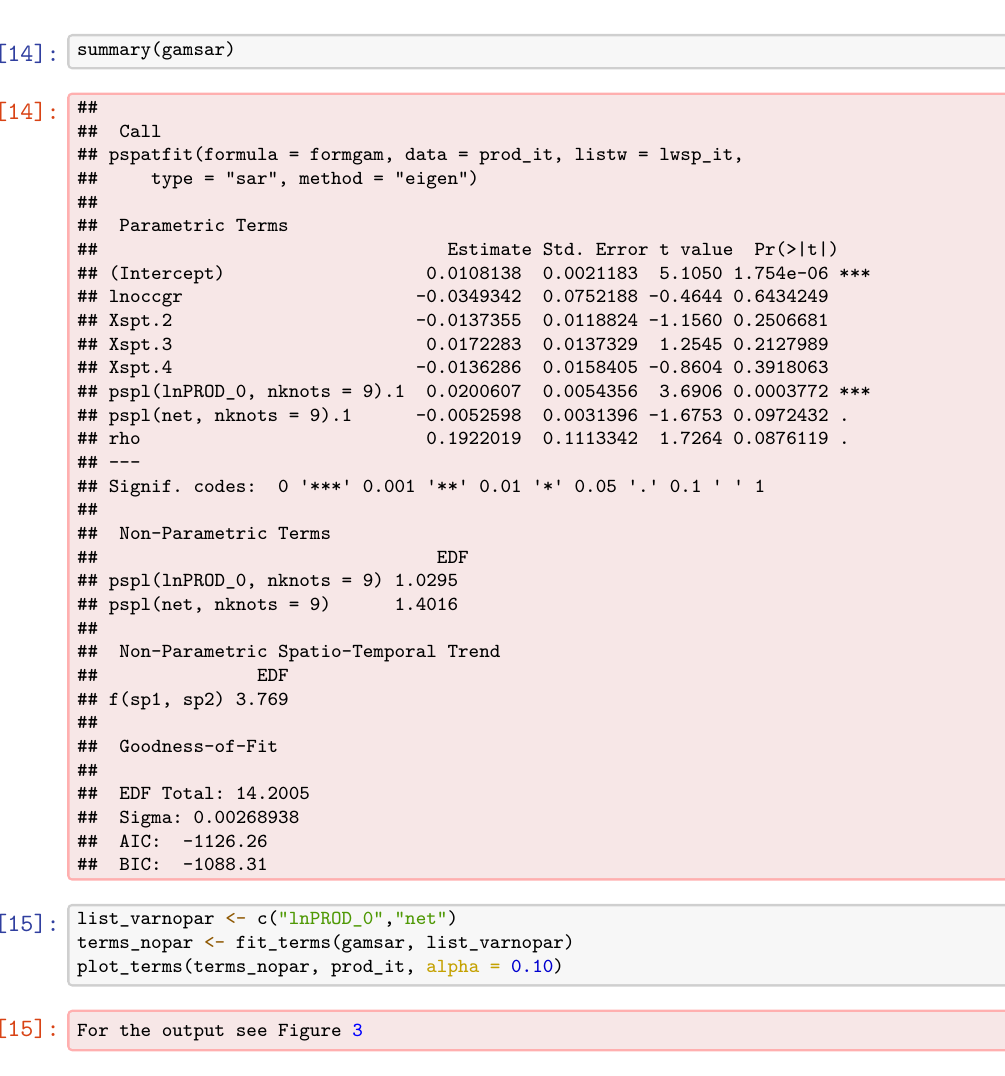
Figure 2: Output from codebox